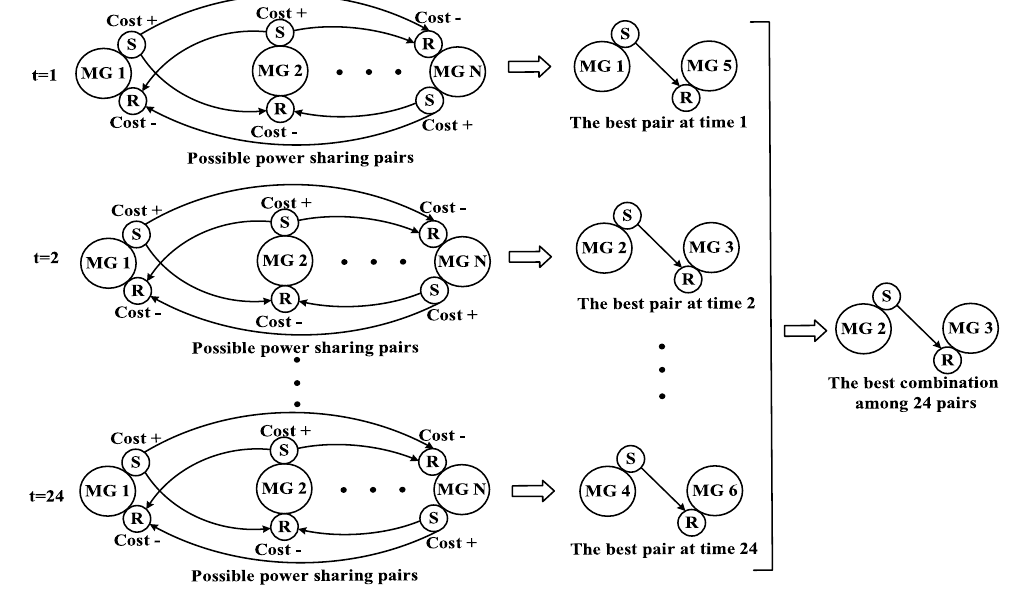
Figure 3. The process employed to select the best power sharing pair in each iteration.